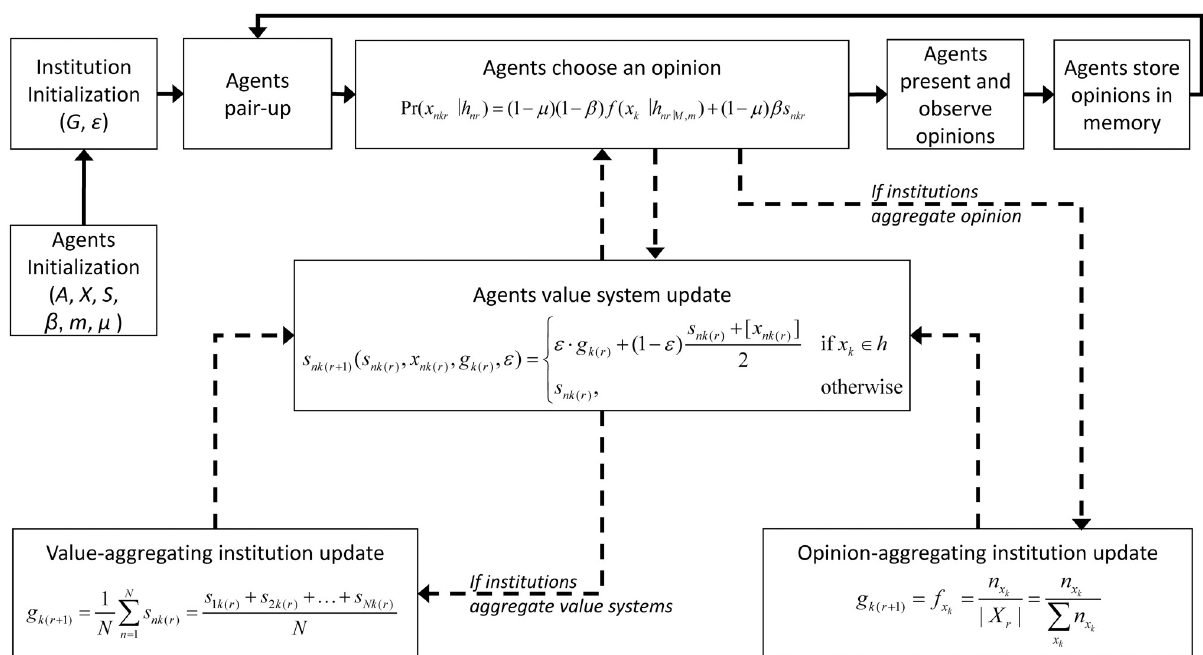
Fig 1. Flowchart depicting relevant activity during one round. Arrow direction represents the time-flow of events. Plain lines represent transition from one event to the following one. Dashed lines represent new data that is used to update the prior information of agents and institutions, affecting agents’ opinion choice over time. We simulated two institutions according to the type of information they aggregate: value-aggregating institutions and opinion-aggregating institutions. Parameters and symbols can be found in Table 1.